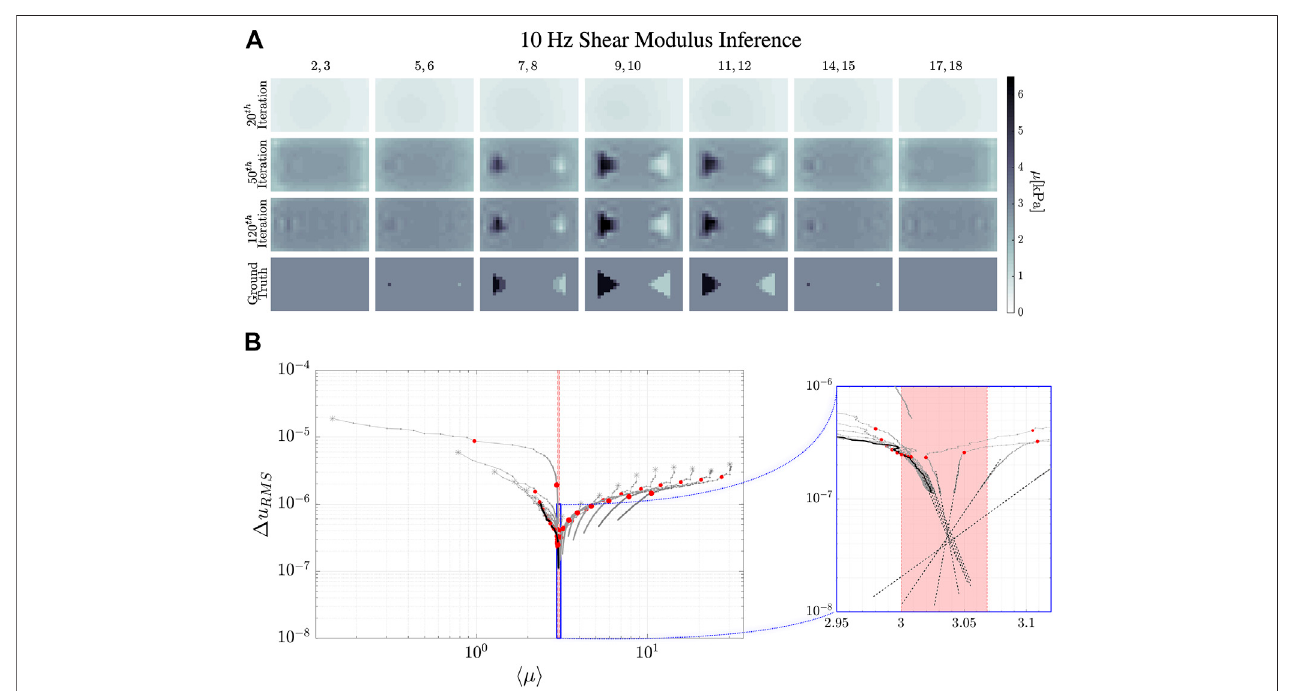
FIGURE5| Reconstructionevolutionoftheshearmodulusinthe10 Hzsimulation. (A) showsthereconstructedimagesoftheshearmodulusdistributioninsidethe simulatedphantom.Thecolumnimagesareaveragesofthenumbered ( xy ) -slices(toprow),eachofwhichis2 mmthick.Therowsarelabeledbytheiterationnumberof the inference. (B) shows the lower dimensional trajectory of the shear modulus. As above, the shear modulus is measured in kilo-Pascals. The smaller diagram is a magni fi edregionneartheconvergedvalues.Initialestimatesarenotedbyanasteriskandchangesindescentstrategyareindicatedbysmallandlargeredmarkers, as explained in the text. The light red region represents the strip between the background value of the shear modulus and the ground truth mean value. The thicker trajectory is the one used to make the images in the above panel. Due to a rather long convergence time, best fi t linear extrapolations of the trajectories are plotted to show that the convergence region is (nearly) the same for all converging runs.